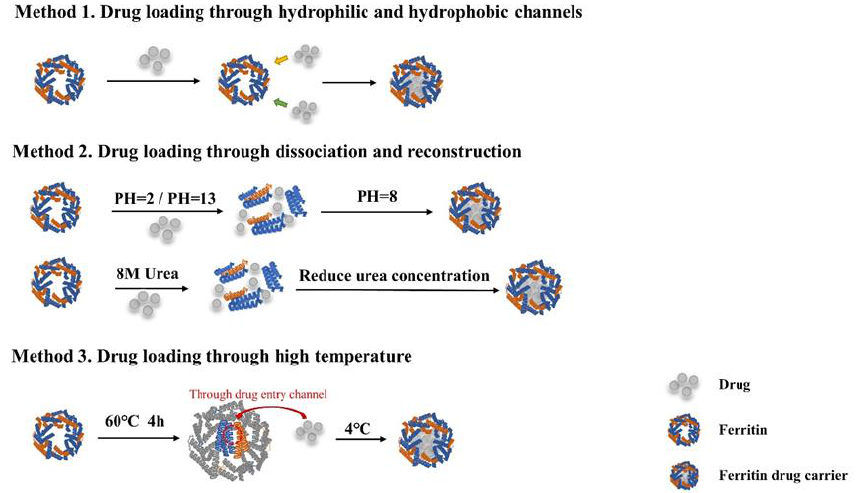
Figure 6. Three drug loading methods of ferritin.